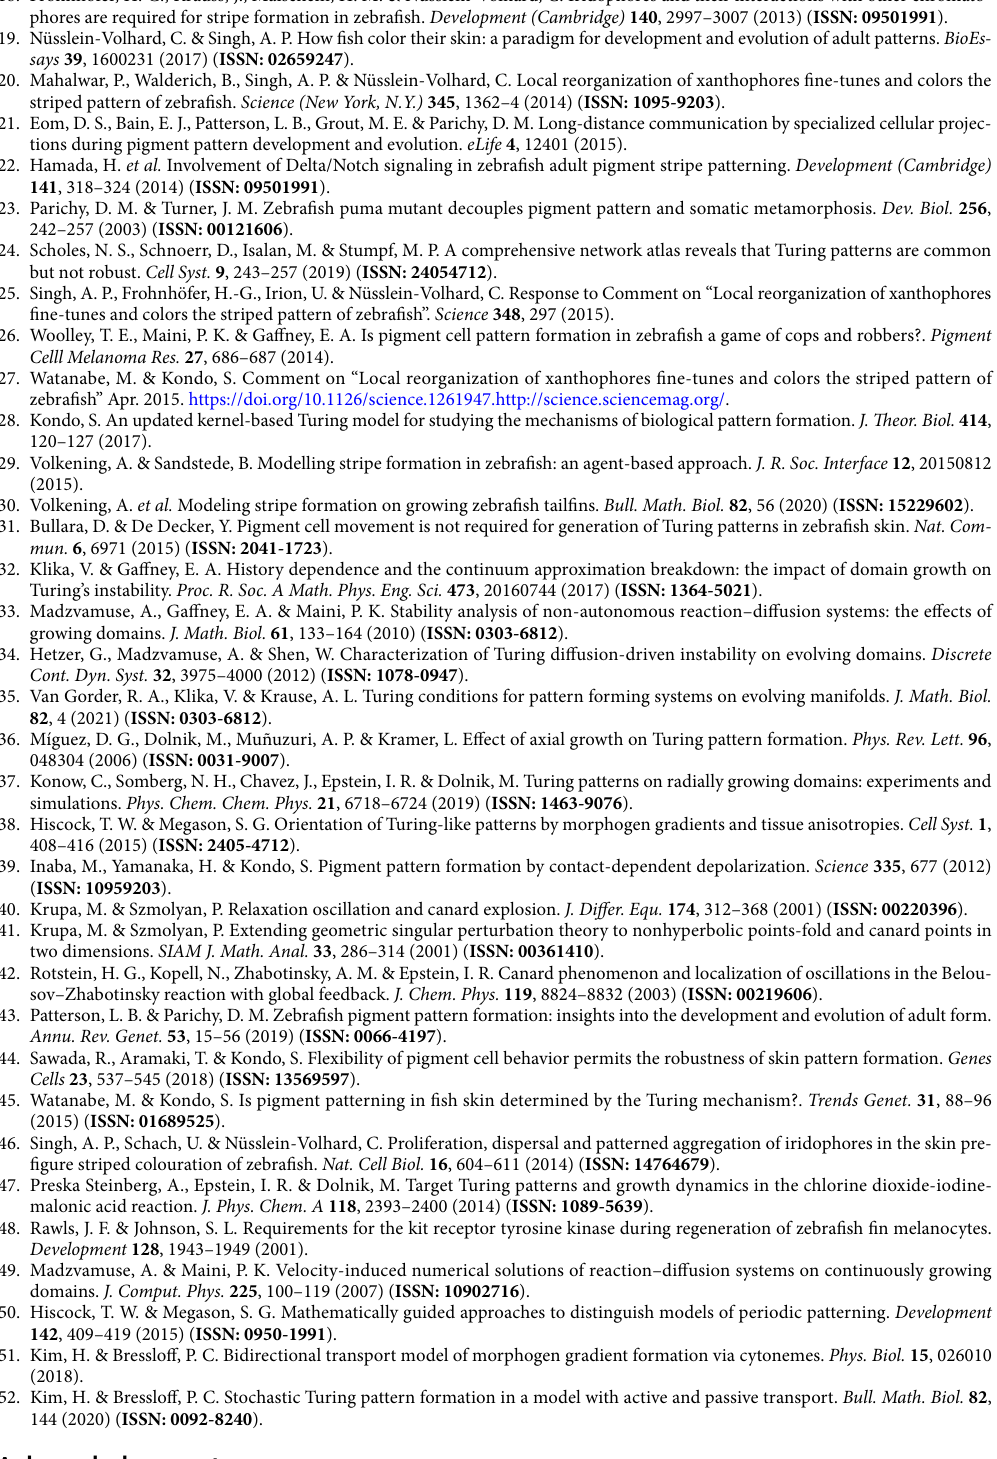
figure striped colouration of zebrafish. Nat. Cell Biol. 16 , 604–611 (2014) ( ISSN: 14764679 ). 47. Preska Steinberg, A., Epstein, I. R. & Dolnik, M. Target Turing patterns and growth dynamics in the chlorine